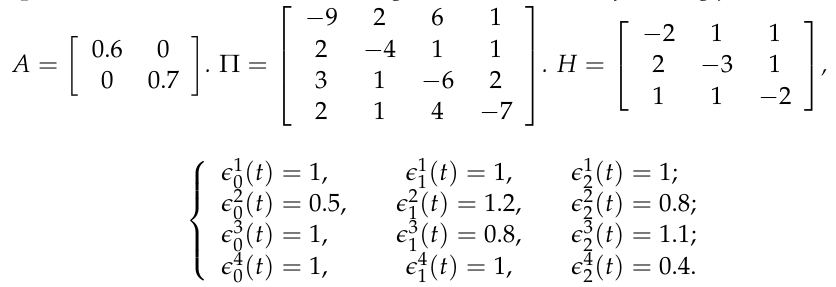
Figure 13. Triggering time instants and their duration in the improved event-triggered scheme for (cid:101) 0 ( t ) = 0, (cid:101) 2 ( t ) = 0, (cid:101) 3 = 0.8 in Example 1. The triggering became linearlike. Example 2. Consider CDNs (7) containing three nodes with the following